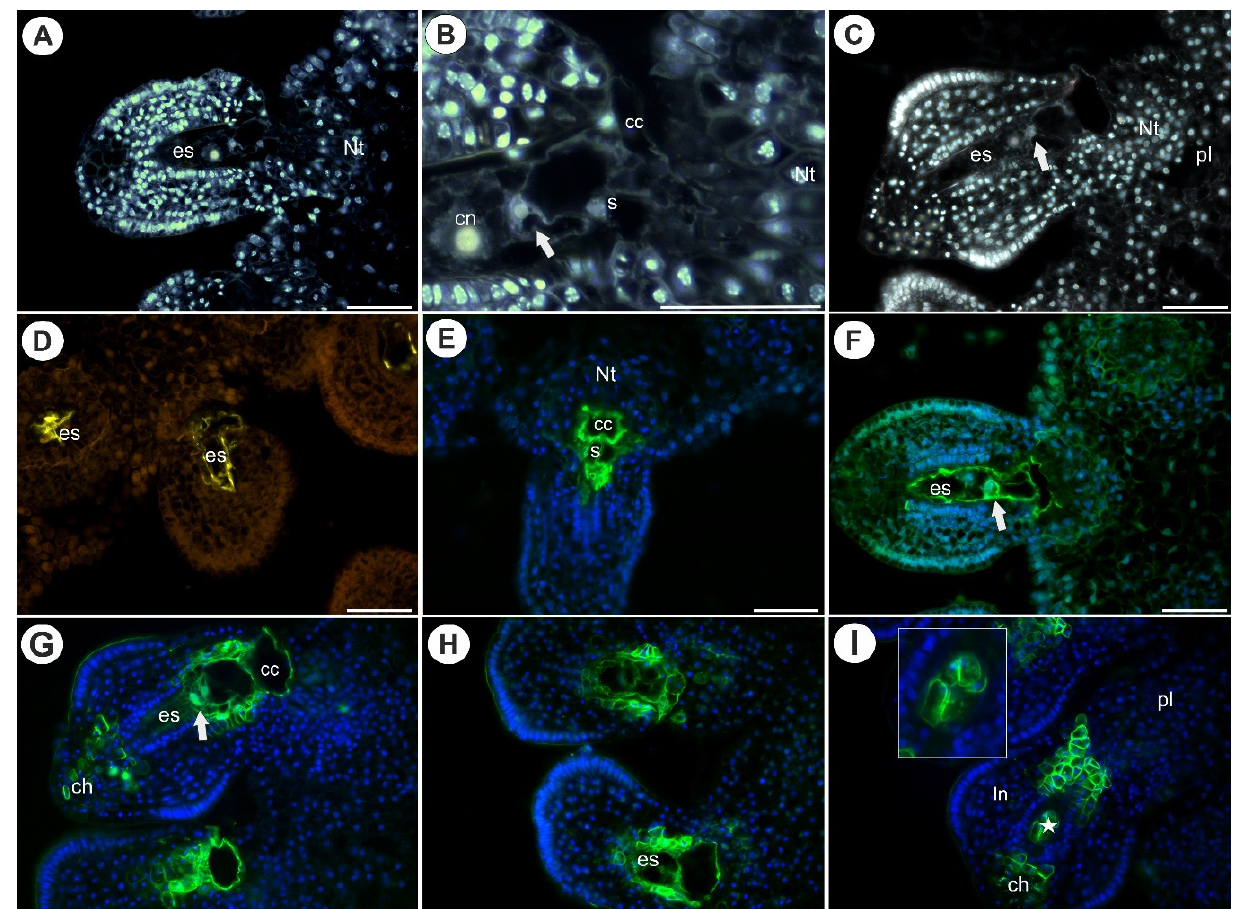
Figure 2. Histology and AGP (JIM13) detection in an ovule of Utricularia nelumbifolia and Utricularia humboldtii before pollination. ( A ) Section through the ovule and placenta of U. nelumbifolia (stained with DAPI, blue fluorescence); note the presence of a mature embryo sac (es), placental nutritive tissue (Nt). ( B ) U. nelumbifolia (stained with DAPI, blue fluorescence), higher magnification of the micropylar part of the ovule and embryo sac; note the egg cell (arrow), synergid (s), nucleus of the central cell (cn), hypertrophied part of the central cell (cc), placental nutritive tissue (Nt). ( C ) Section through the ovule and placenta of U. humboldtii (stained with DAPI, blue fluorescence); note the presence of a mature embryo sac (es), egg cell (arrow), placental nutritive tissue (Nt), placenta (pl). ( D – F ) Arabinogalactan protein (labeled with JIM13, green fluorescence) detected in U. nelumbifolia : embryo sac (es), egg cell (arrow), synergid (s), hypertrophied part of the central cell (cc), placental nutritive tissue (Nt); yellowish signal is autofluorescence. ( G , H ) Arabinogalactan protein (labeled with JIM13, green fluorescence) detected in U. humboldtii : embryo sac (es), egg cell (arrow), hypertrophied part of central cell (cc), placental nutritive tissue (Nt), chalaza (ch). ( I ) Arabinogalactan protein (labeled with JIM13, green fluorescence) detected in the ovule of U. humboldtii that did not contain a mature female gametophyte. Note the occurrence of AGPs in remaining nucellus epidermis (star, and framed part), integument (In), chalaza (ch), placenta (pl). All bars 50 µ